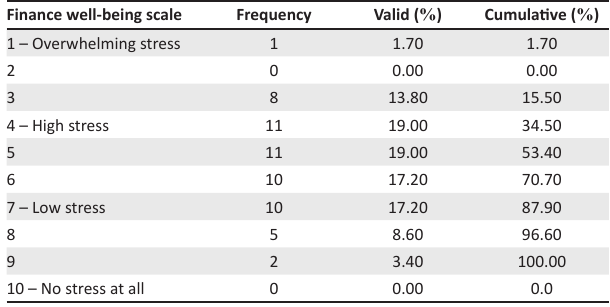
TABLE 8: How stressed do you feel about your personal finances in general? Finance well-being scale